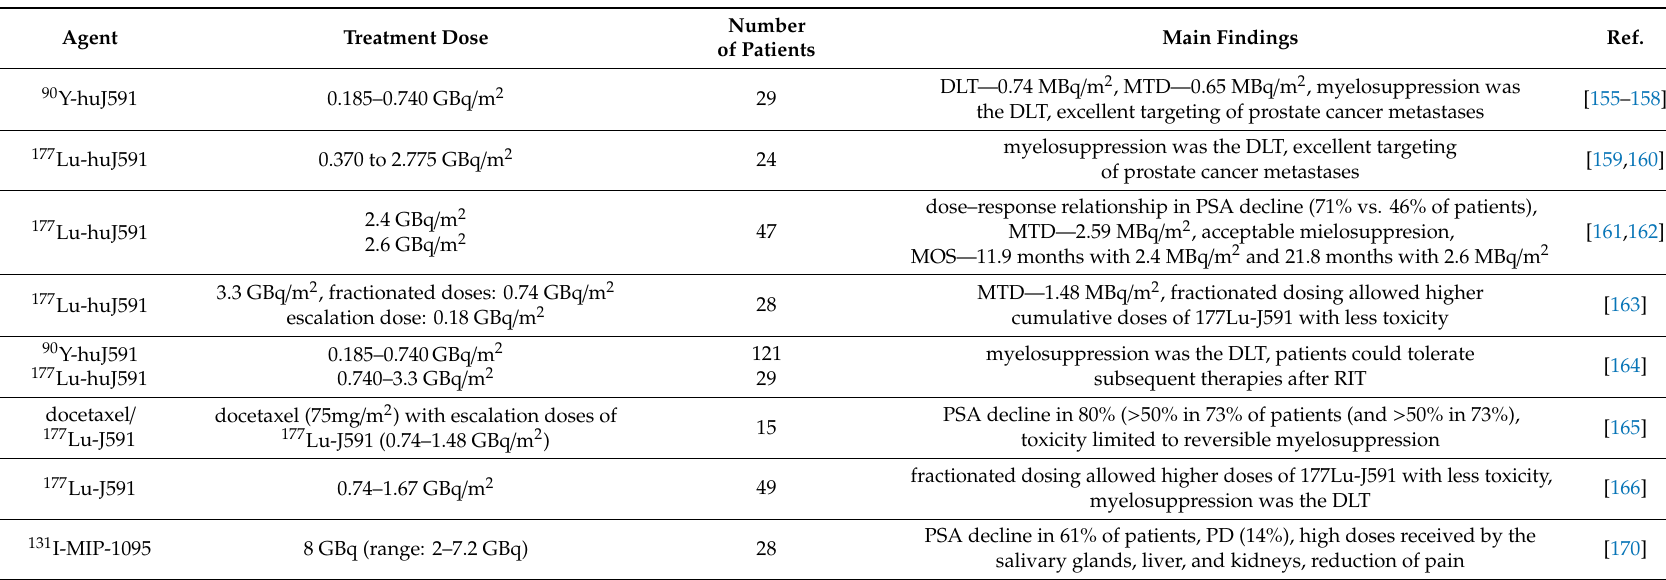
Table 3. Clinical studies of radiopharmaceuticals for targeted prostate cancer therapy (DLT—dose limiting toxicity; MTD—maximal toxic dose; PD—progressive disease, PFS—progression-free survival; MOS—median overall survival;